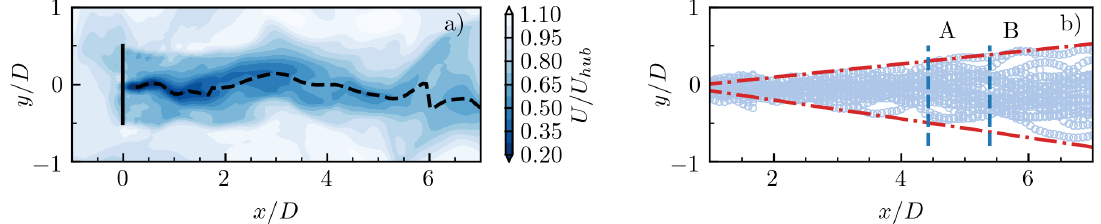
Figure 16. Wake meandering. The instantaneous centerline of the meandering velocity deficit is shown in ( a ). The superposition of centerlines is shown in ( b ). The dotted and dashed lines in ( b ) are the edges extracted from the superposition of centerlines at all timesteps, while the circles are the wakeline at 25 random timesteps. The dashed lines A and B in ( b ) are the locations where the centerline may collide with the tip